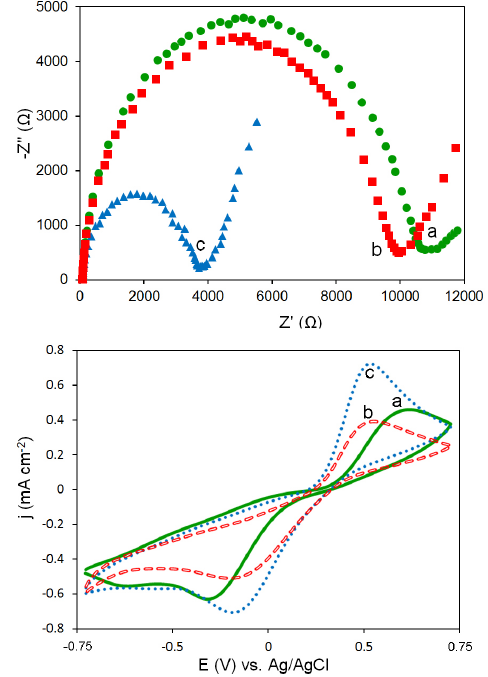
Figure 4: A and B: Nyqust plots and Cyclic voltammograms for a) FTO electrode, b) GO, and c) MeGO on the FTO surface in 5 mM K 3 Fe(CN) 6 and 0.01 M